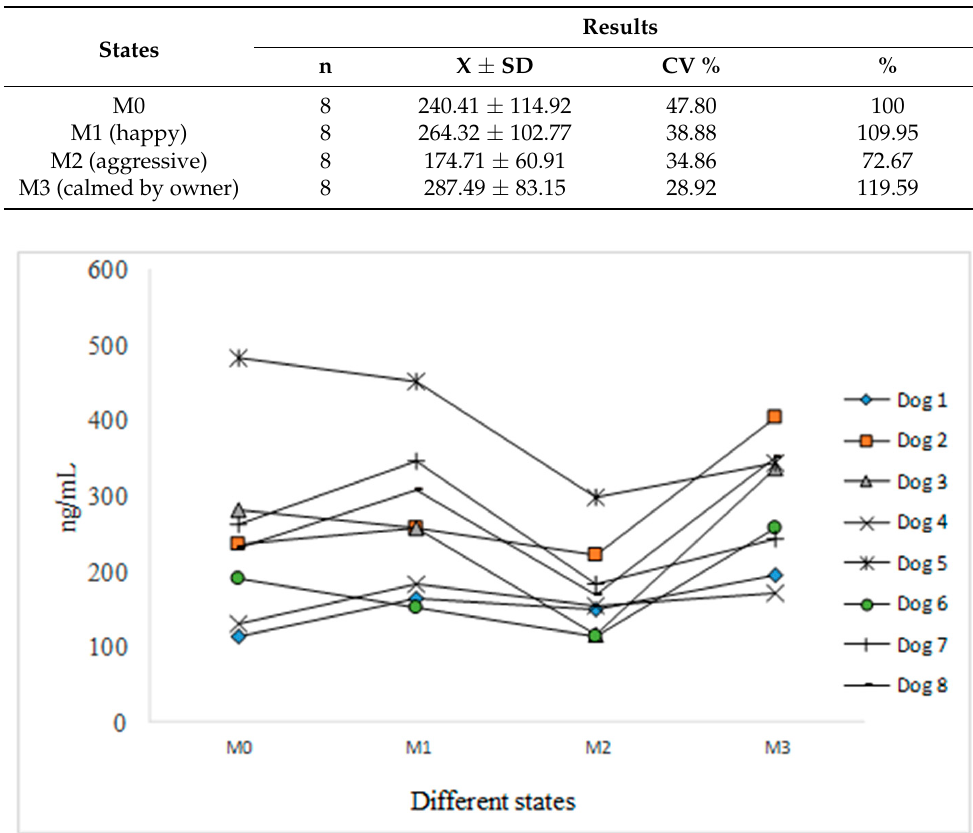
Table 3. The results of the serotonin value depending on the degree of individual involvement.